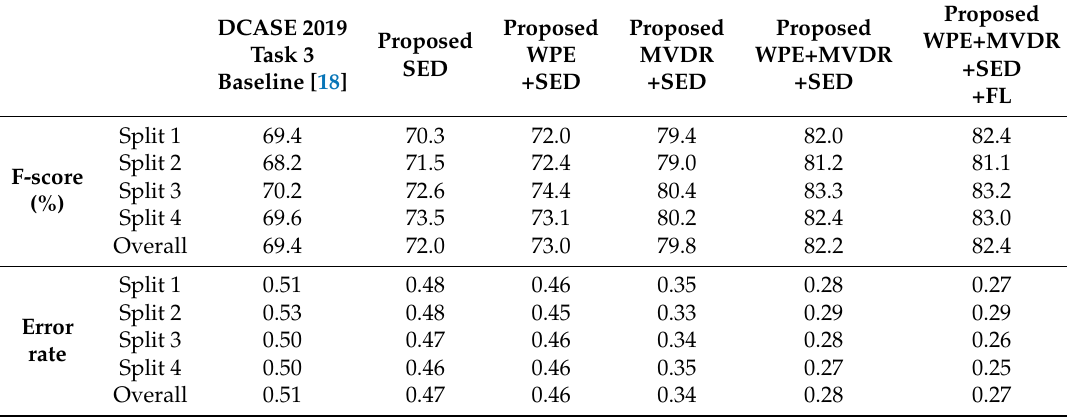
Table 5. F-score and ER results at 10 dB SNR: Ambisonic development